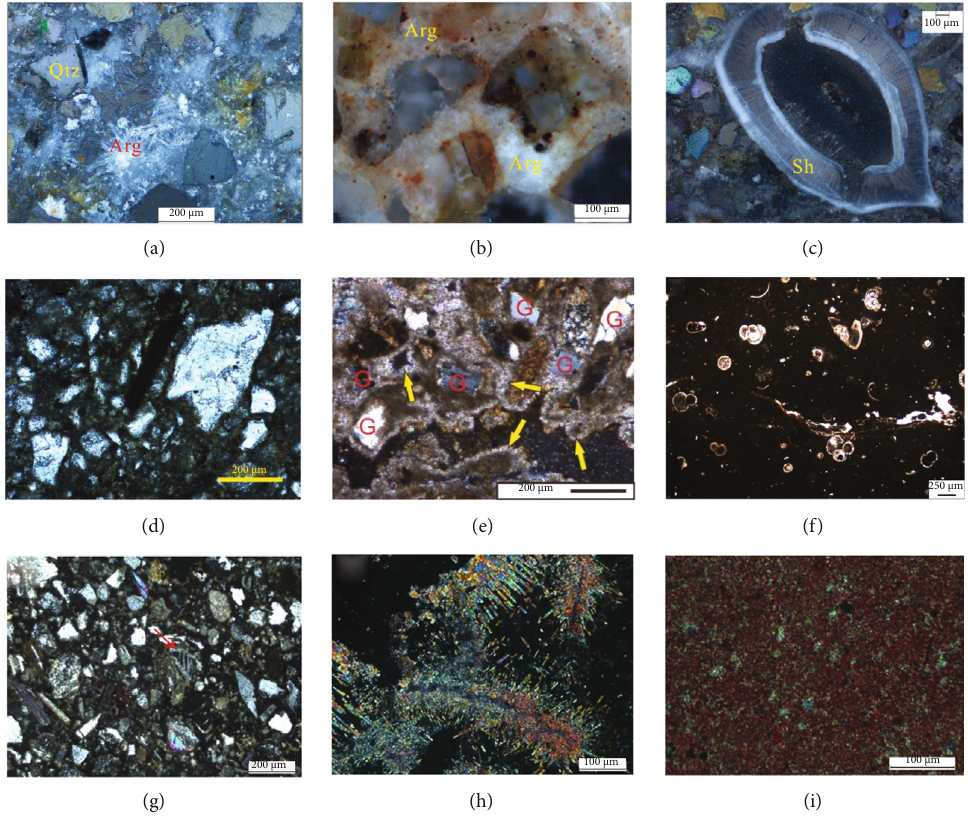
Figure 8: Thin-section microphotos of the carbonate samples in the Okinawa Trough. (a) Radial fi brous aragonite crystals (transmitted polarized light). (b) Antigenic carbonate stained by brown goethite (re fl ected polarized light). (c) Well-preserved shell fragments (Sh) cemented by microcrystalline aragonite (transmitted polarized light). Qtz: quartz; Arg: aragonite. Panels (a – c) are from [27]. (d) Typical features of inequigranular texture and angular shapes within the carbonate chimney (from [18]). (e) Angular grains (G) surrounded by authigenic carbonates and stained by Fe oxide. The early microlite carbonates are immediately encircled by the later bright carbonate rims (marked by yellow arrows, from [25]). (f) Typical features of the carbonate matrix of the cored samples (from [19]). (g) Feldspar replaced by micritic dolomite. (h) Acicular aragonite replaced by micritic dolomite. (i) Aragonite cement in the crust. Panels (g – i) are from